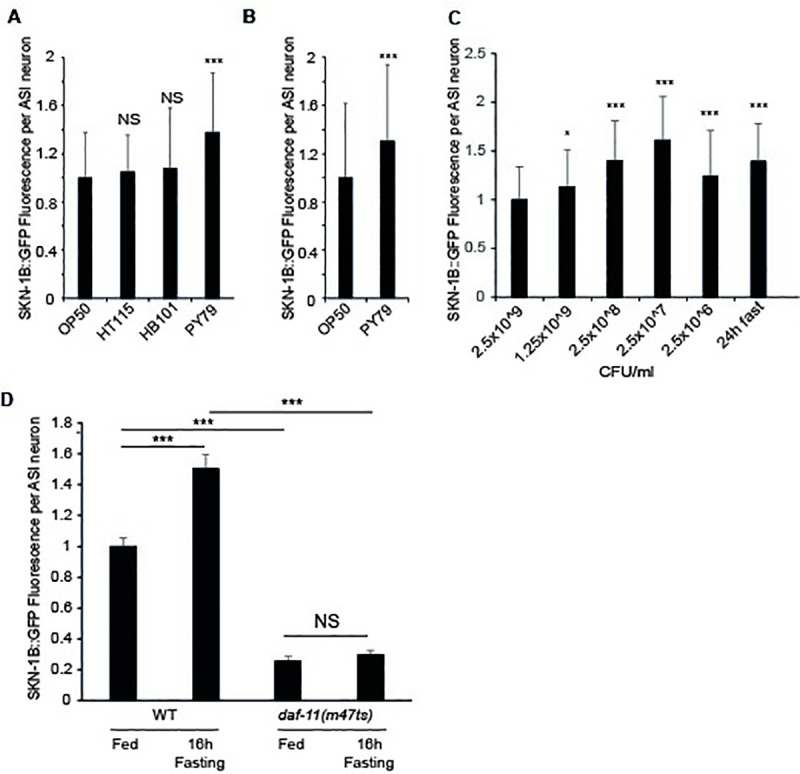
SKN-1B::GFP levels respond to nutritional cues and require daf-11.A-D) Quantitative fluorescence microscopy of SKN-1B::GFP in response to: A) different bacterial strains, B) being switched to PY79 at the L4 stage, C) 24hrs bacterial dilution [12], or C) 16hrs fasting. For D) a combination of daf-11 mutation and fasting was used. Similar results to those in C) had previously been observed using a SKN-1B/C::GFP transgene [12]. A-D) Imaged at 1 day adults, each bar is the mean of 3 biological replicates ± st. dev. Two-tailed t-test *p<0.05, ***p<0.0001, NS not significant.